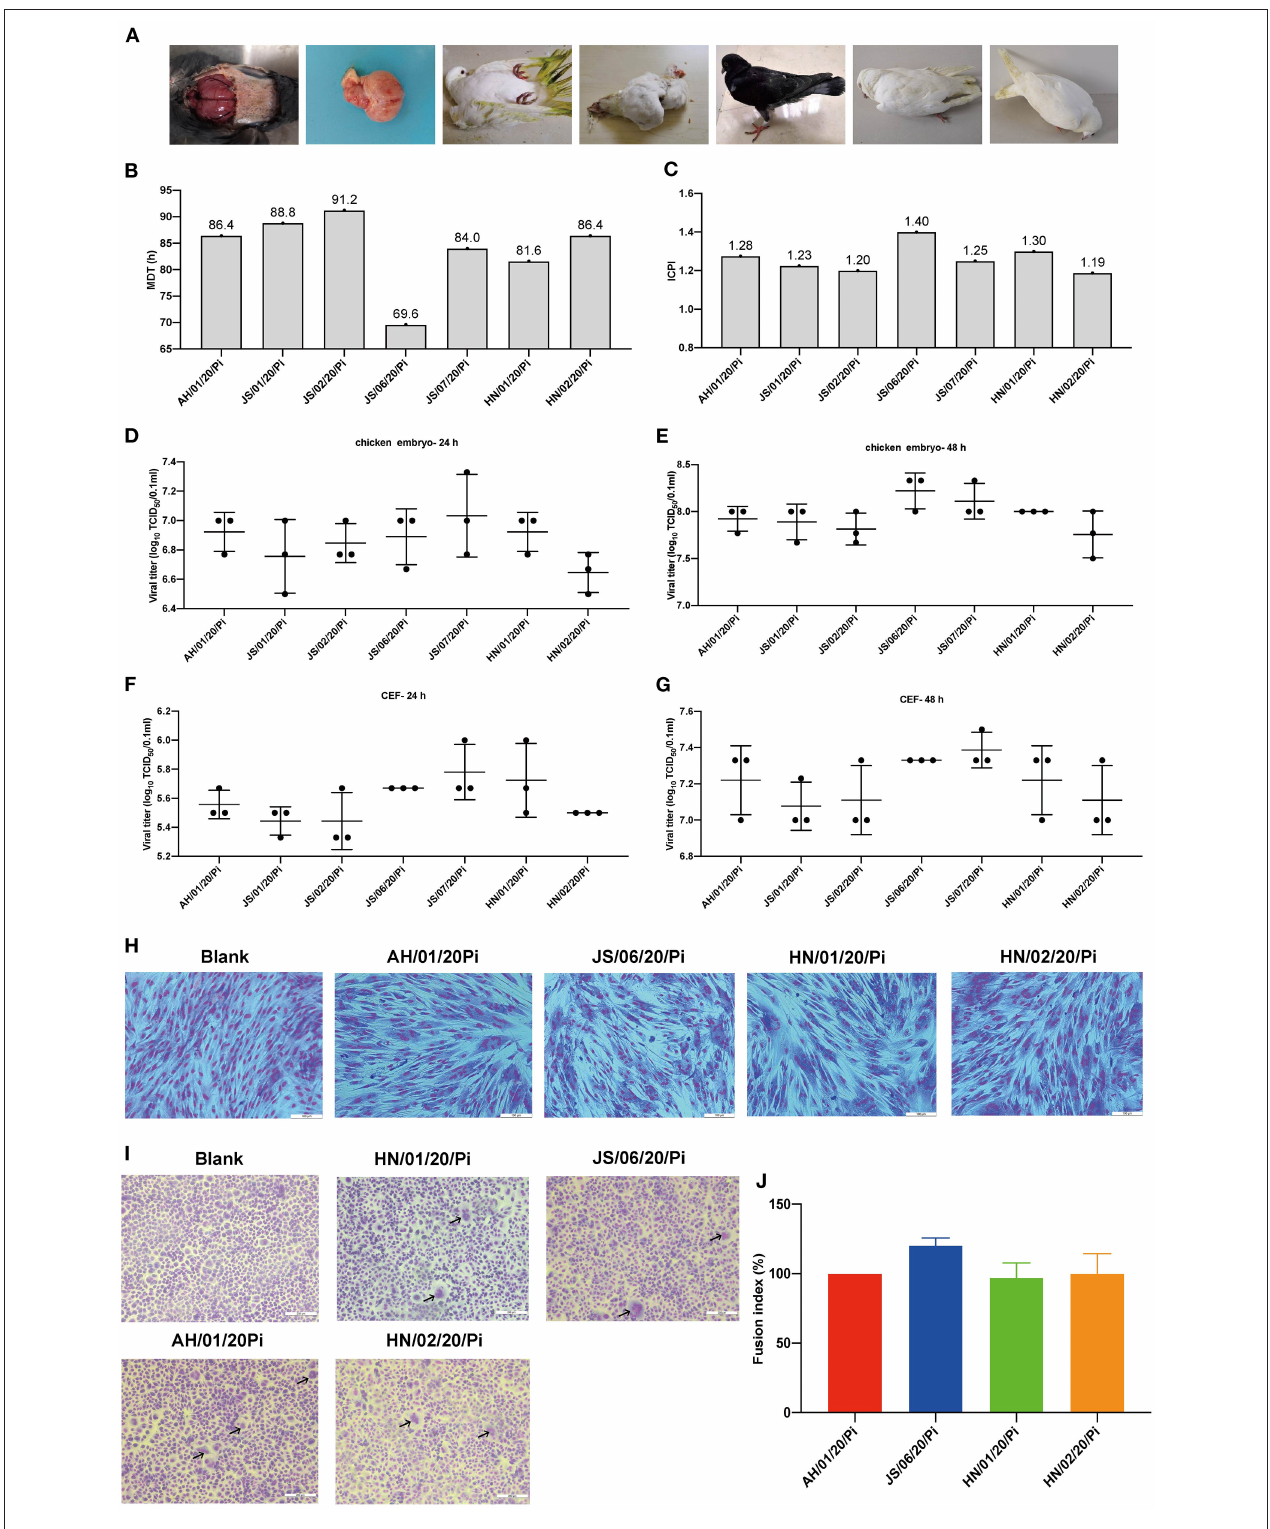
FIGURE 1 | Isolation and biological characteristics of 7 PPMV-1 isolates in this study. ( A) Clinical signs and gross lesions of diseased pigeons from different provinces. The pathogenic potential of these isolates was determined using the MDT (B) and ICPI (C) assays. The growth kinetics of different PPMV-1 isolates in 10-day-old